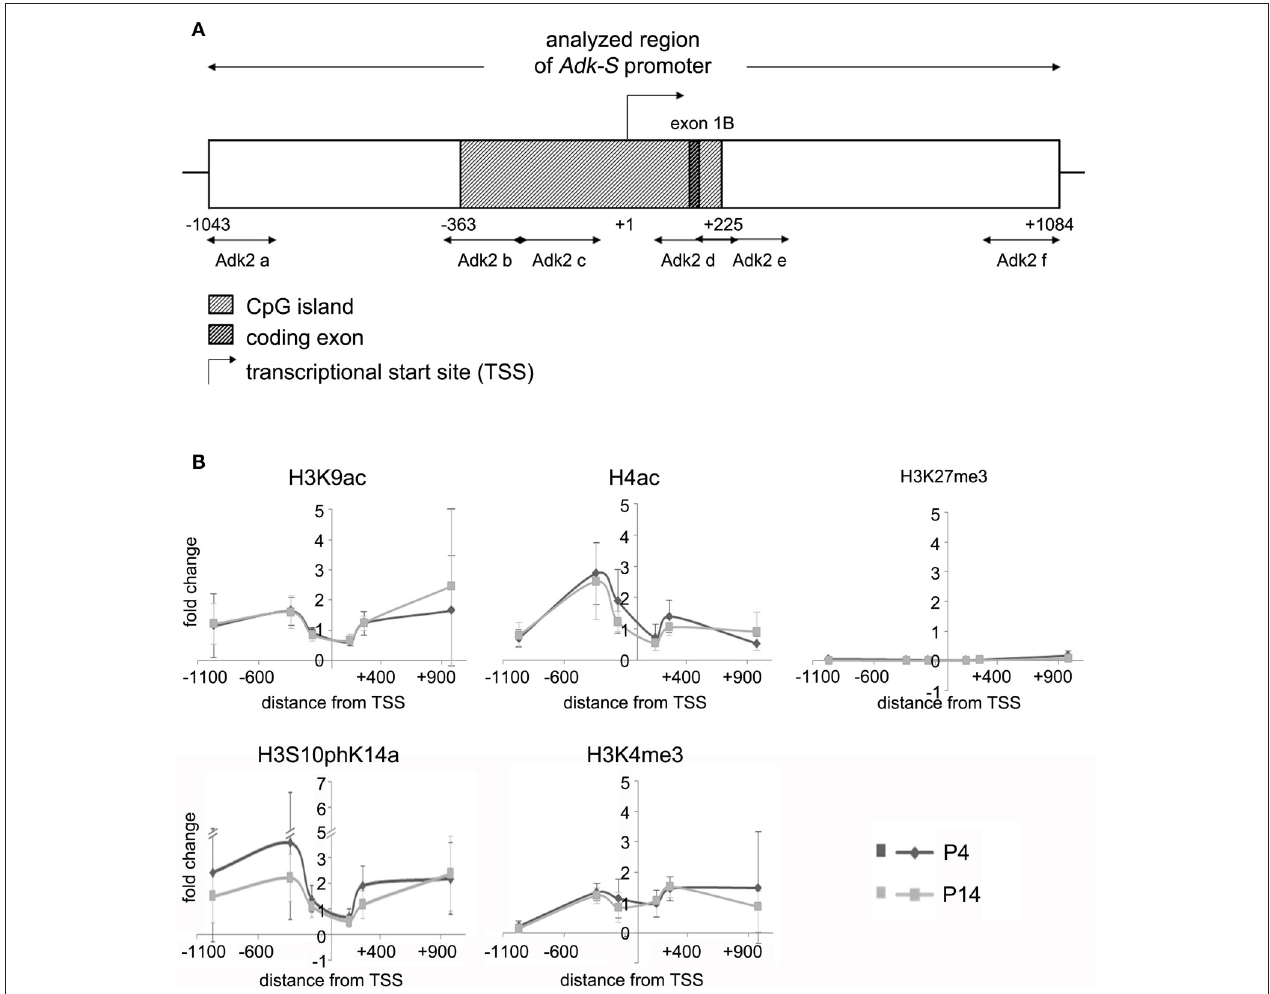
FIGURE 3 | Impact of epigenetic chromatin modifications on Adk-S promoter activity in P4 and P14 rat hippocampal neurons. (A) Promoter region of the short Adk isoform was analyzed from pos. − 1043 to + 1084 relative to the TSS. (B) Enrichment of activating histone modifications at the Adk-S promoter in both P4 and P14 hippocampal neurons, including acetylation of H3 and H4, as well as H3 phosphoacetylation and lysine 4 trimethylation, particularly upstream of the TSS was identified. No evidence for repressive H3K27 trimethylation. Adk-S promoter, promoter regulating short Adk isoform expression; ChIP, chromatin immunoprecipitation; H3K9ac, acetylation of lysine (K) 9 of histone H3; H4ac, pan-acetylation of histone H4; H3S10phK14ac, phosphoacetylation of histone H3 targeting Serine (S) 10 and Lysine (K) 14; H3K4me3, trimethylation of lysine (K) 4 of histone H3; H3K27me3, trimethylation of lysine (K) 27 of histone H3; Hist1H4B, Histone cluster 1, H4B; MyoD, Myogenic differentiation 1; TSS, transcriptional start